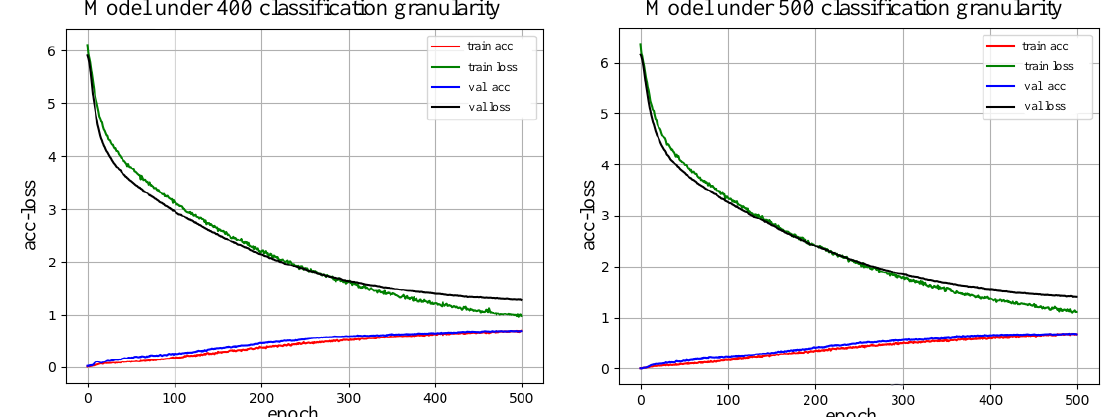
Figure 9. Effect of curve fitting under different classification granularities.